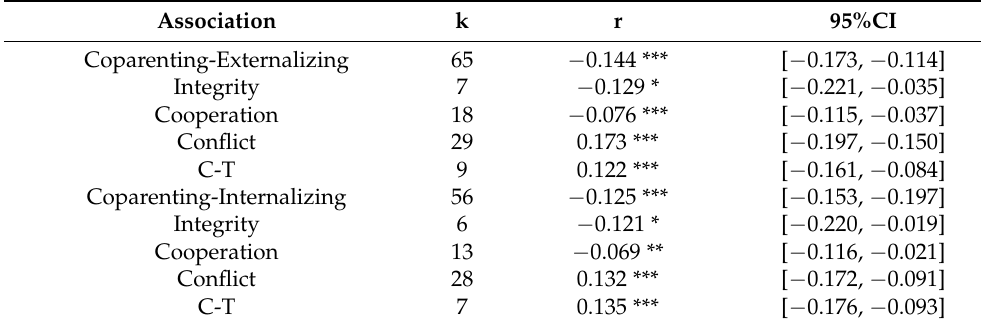
Table 3. Coparenting as a predictor of change in child adjustment. Association